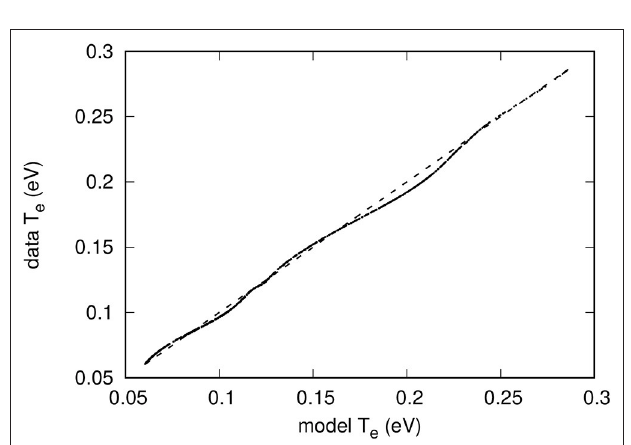
FIGURE 5 | Comparison between model-predicted and actual data temperature values. The model used here was constructed with a direct optimization of six pivots. The dashed line corresponds to a perfect correlation between the two temperatures.